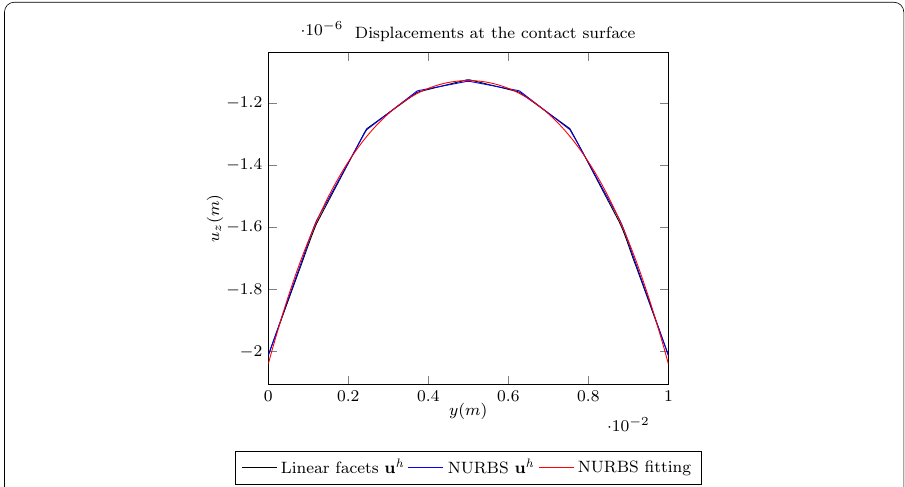
Fig. 10 Example 1: FE displacements u h over the top surface of the lower solid considering linear facets and NURBS fitting definitions. The curve in red depicts the solution of the NURBS fitting problem